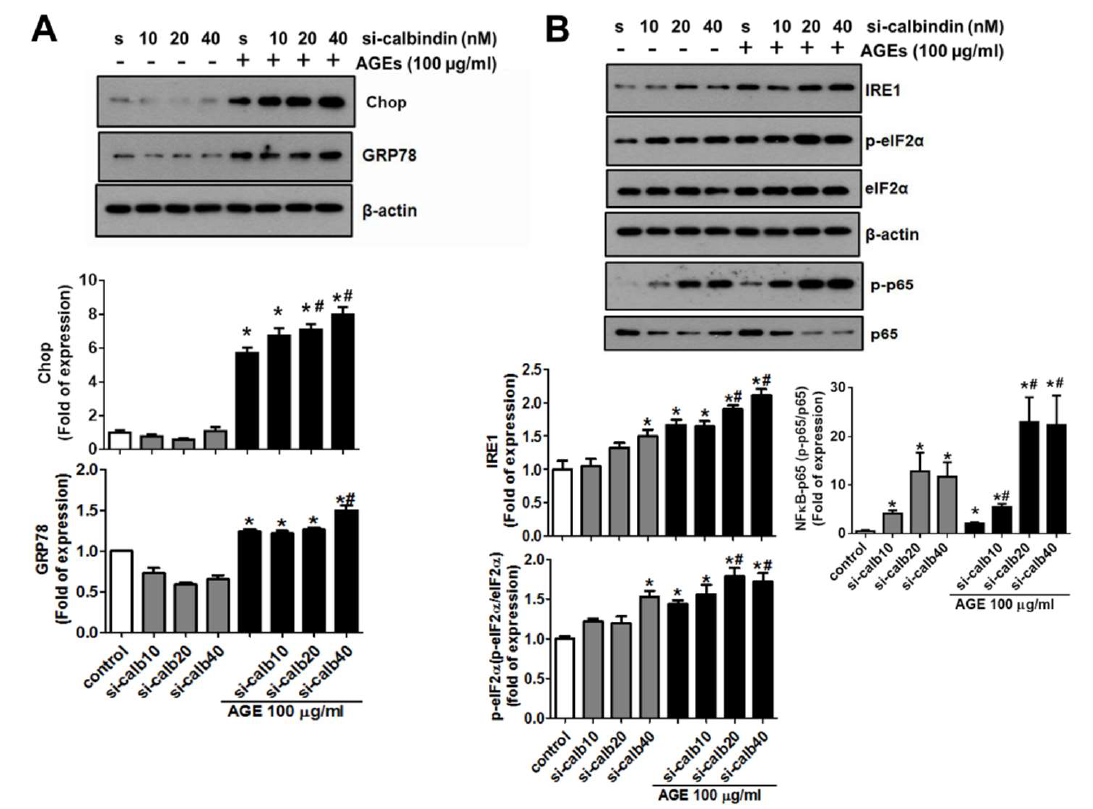
Figure 5. Calbindin-D28k silencing enhanced AGEs-induced ER stress signals in HK2 cells. Cells were transfected with scramble (s or control; 40 nM) or calbindin-D28k siRNA (si-calbindin or si-calb10-40; 10–40 nM) for 6 h. Transfected cells were treated with or without AGEs (100 µ g / mL) for 48 h. Protein expressions of CHOP and GRP78 ( A ) and IRE1, phosphorylated eIF2 α (p-eIF2 α ), eIF2 α , NF κ B-p65, and phosphorylated NF κ B-p65 ( B ) were performed by Western blotting. Protein levels were quantified by densitometry and normalized by β -actin or eIF2 α or NF κ B-p65 levels. Data are presented as means ± SEM (n = 5). * P < 0.05, vs. scramble control group. # P < 0.05, vs. AGEs + scramble group.